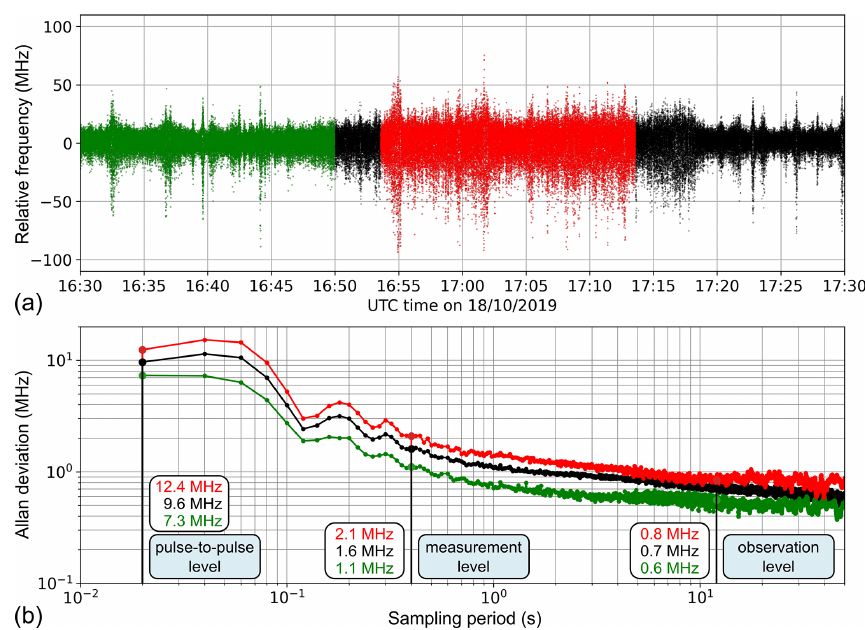
Figure 11. Laser frequency stability on the pulse-to-pulse level for the period from 16:30 to 17:30UTC on 18 October 2019 (see also Fig. 10). (a) Time series of the relative frequency. From the overall 1h period, two intervals of 20min with good (green) and poor frequency stability (red) were selected for further analysis. Panel (b) represents the Allan deviation calculated for the selected time series in the upper panel. The dashed vertical lines indicate sampling periods relevant for the wind retrieval (pulse-to-pulse level: 0.02s; measurement level: 0.4s; observation level: